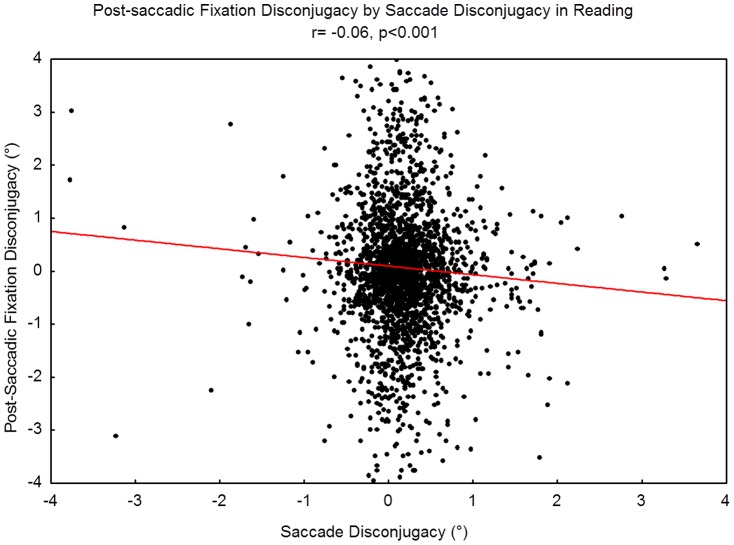
Correlations between saccadic disconjugacy and post-saccadic fixation disconjugacy for each saccade analyzed.